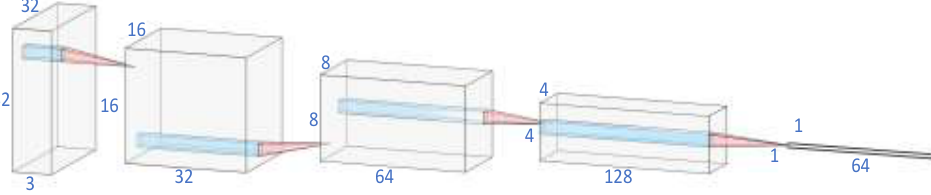
Figure 3. The process of feature extraction.